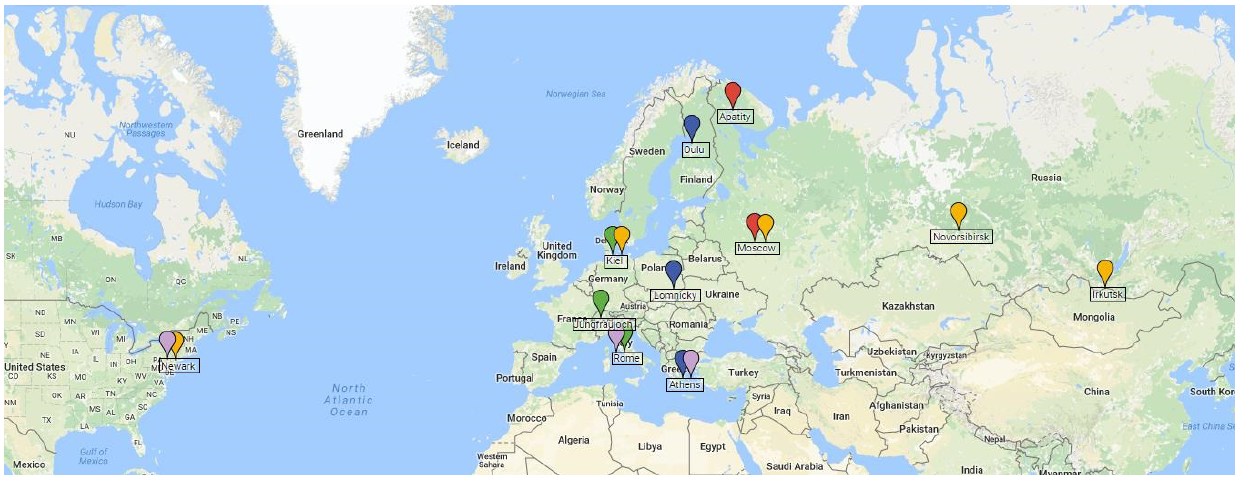
Figure 1. A map giving the geographic locations of the NM stations used in this work. The grouped stations are indicated by the same